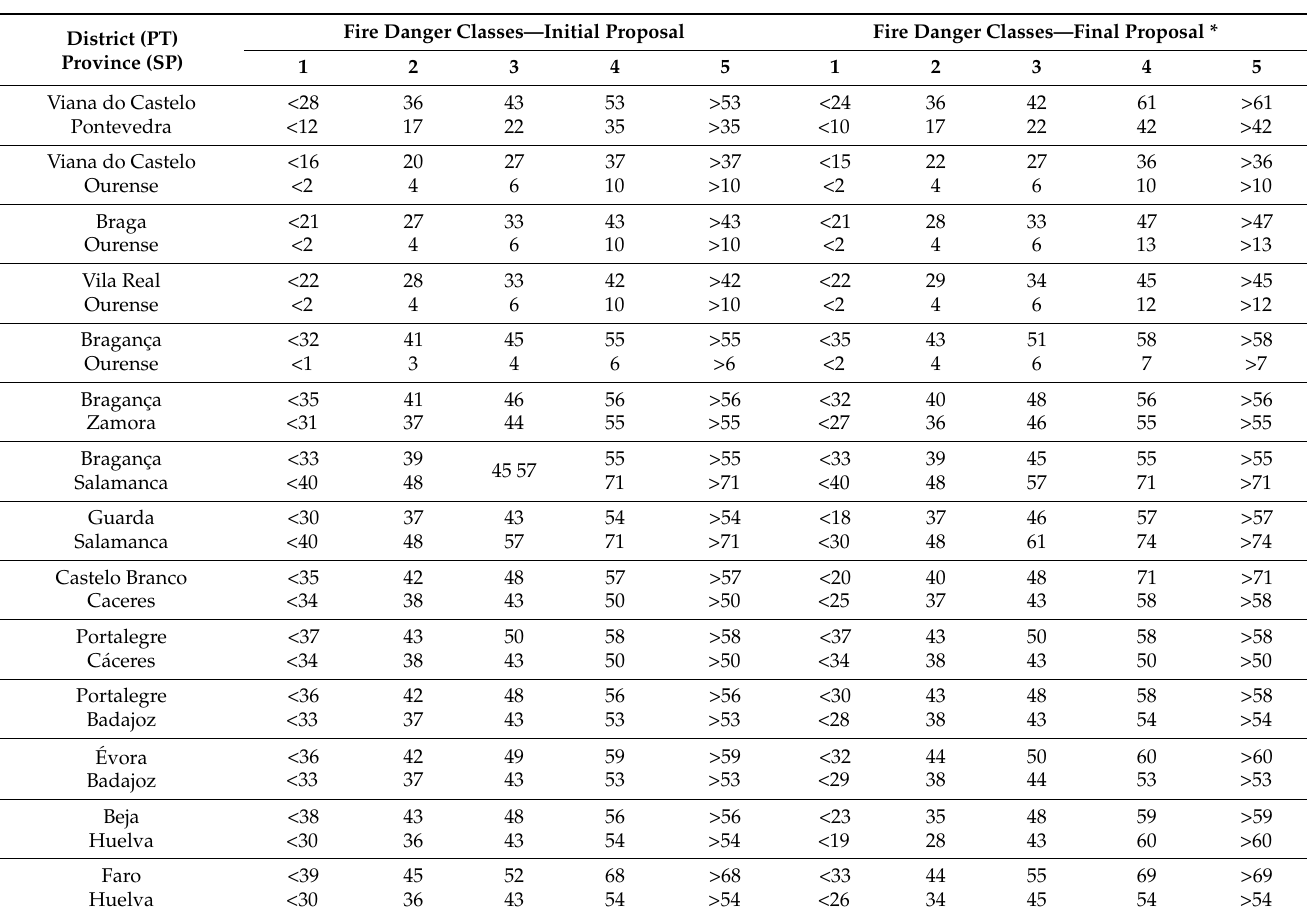
Table 3. FWI values that limit the fire danger classes according to the initial and final proposal. Classes names: 1—Low, 2—Moderate, 3—High, 4—Very high, and 5—Maximum.